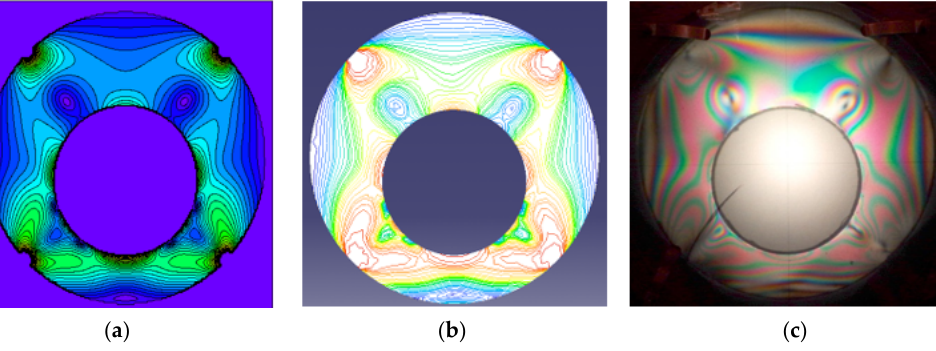
Figure 12. Concordance between the isochromatic fields for the theoretical ( a ), numerical ( b ) and experimental ( c ) results for four concentrated forces, Case f from Table 1.